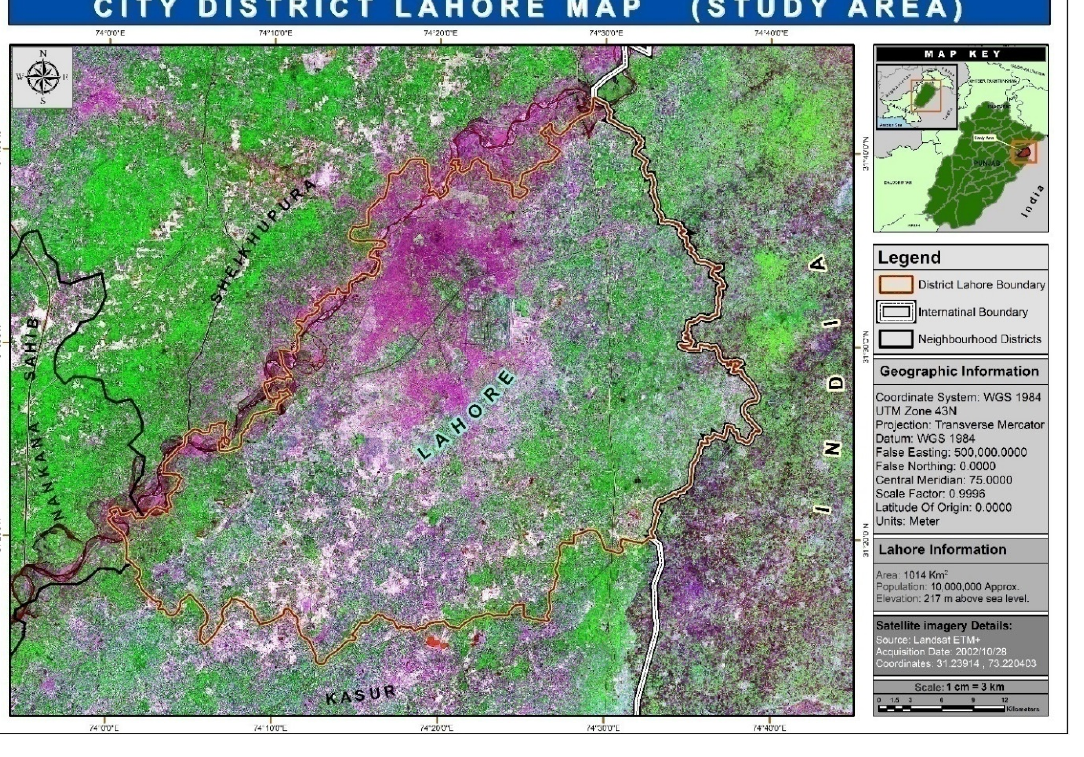
Figure 1. Study Area Map.